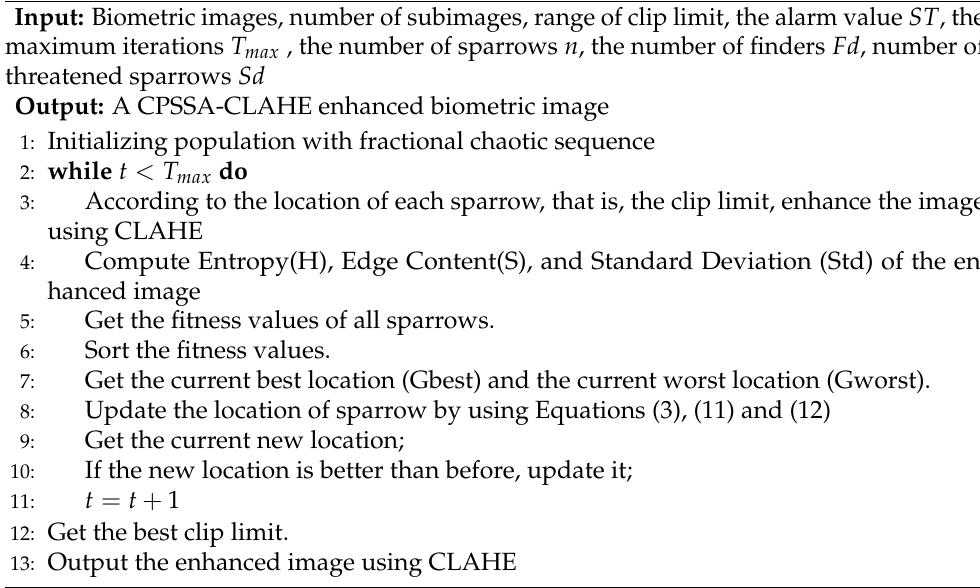
Algorithm 1 CPSSA-CLAHE